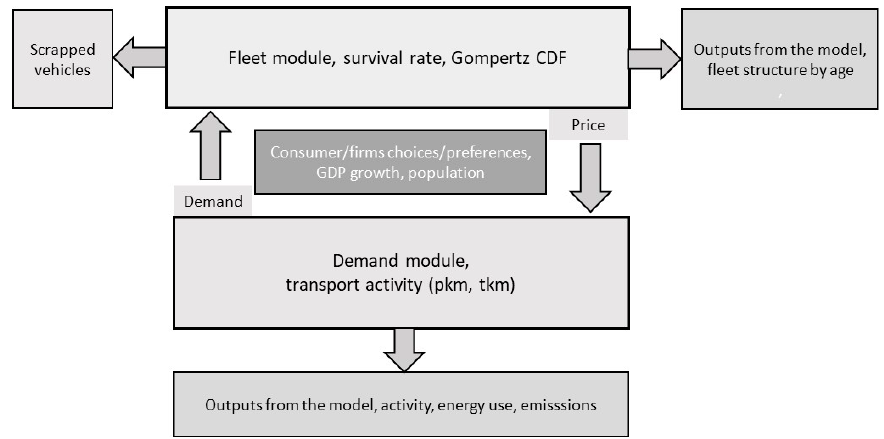
Figure 1. Logic of the TR 3 E transport model. Source: own elaboration.